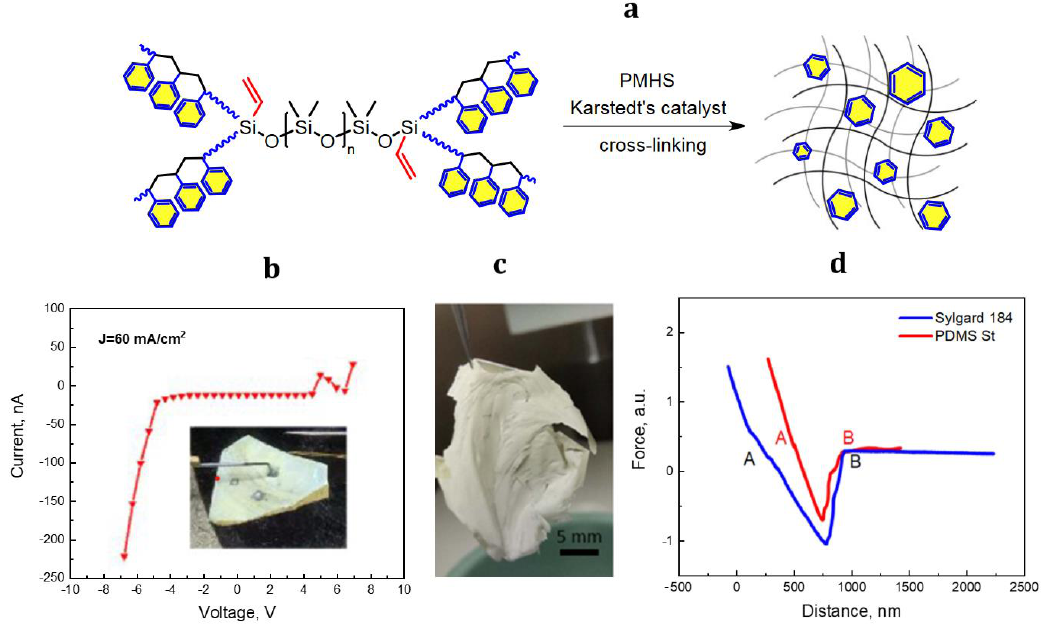
Figure 2. Scheme of PDMS- graft -polystyrene cross-linking ( a ), current-voltage characteristic ( b ). Reproduced with permission [38]. Copyright 2020, Royal Society of Chemistry. Optical photograph ( c ) of the released PDMS- graft -polystyrene (PDMS St)/n-GaP membrane, atomic force microscopy (AFM) approach/retraction curves showing the adhesion of silicone rubbers to Si substrate (distances between points A and B corresponds to the cantilever piezo displacement) ( d ) [56]. Current-voltage characteristics of a p-doped SWCNTs/n-GaP NWs/ PDMS- graft -pol-